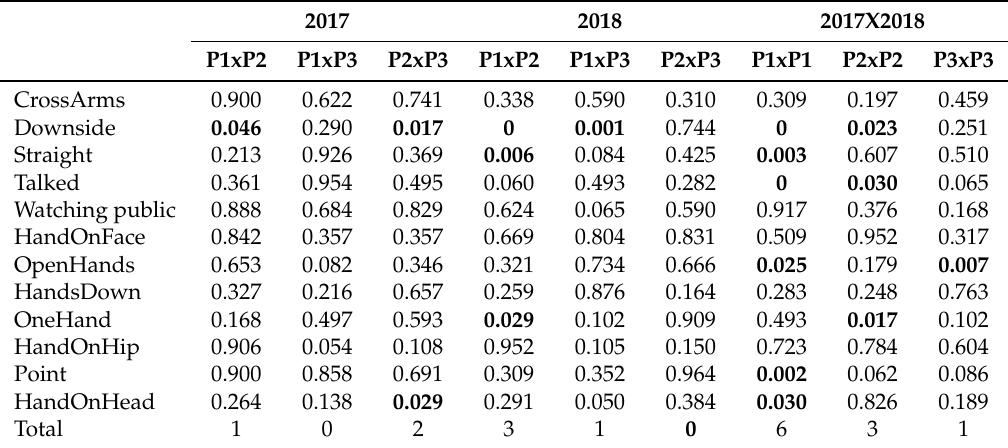
Table 5. Inferential tests between all databases